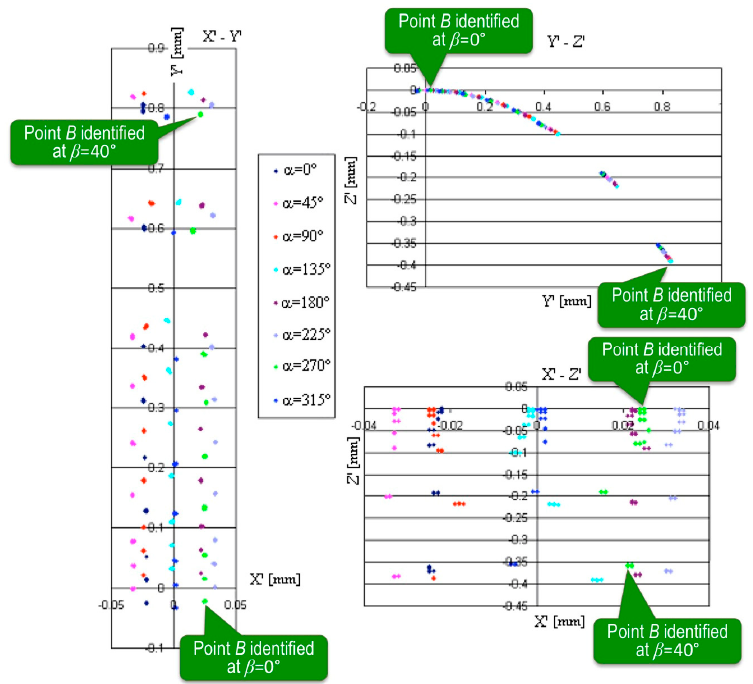
Figure 5. The diagrams x ′ -y ′ , y ′ -z ′ , and x ′ -z ′ of the measurement results of point B on the steel surface (Sample 1) at different angles α and β .